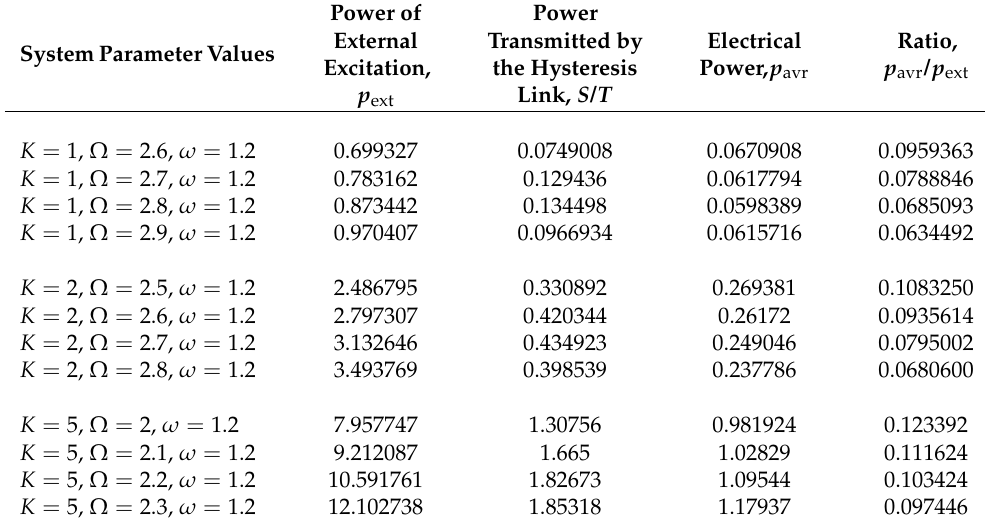
Table 3. Power values at H =